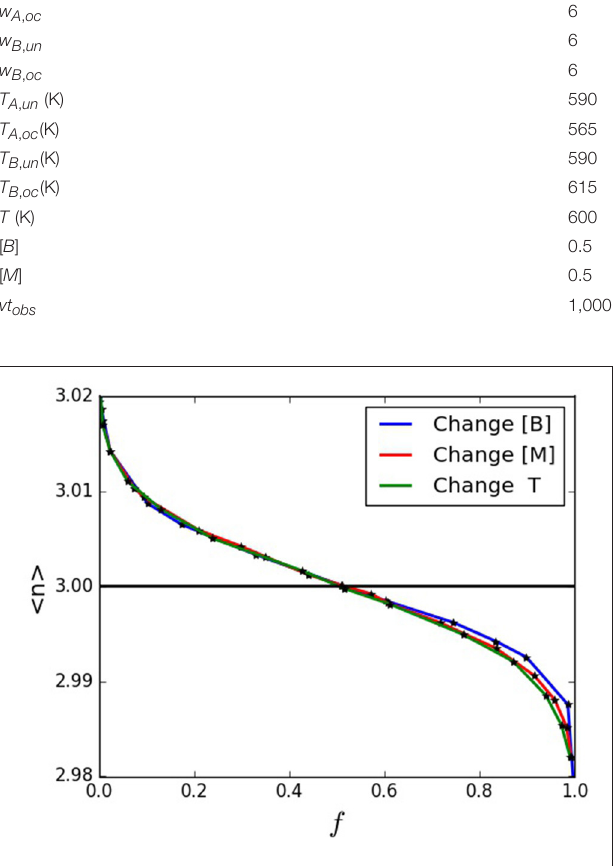
FIGURE 4 | h n i vs. f when varying the concentration of network formers, B, modifiers, M, and temperature,